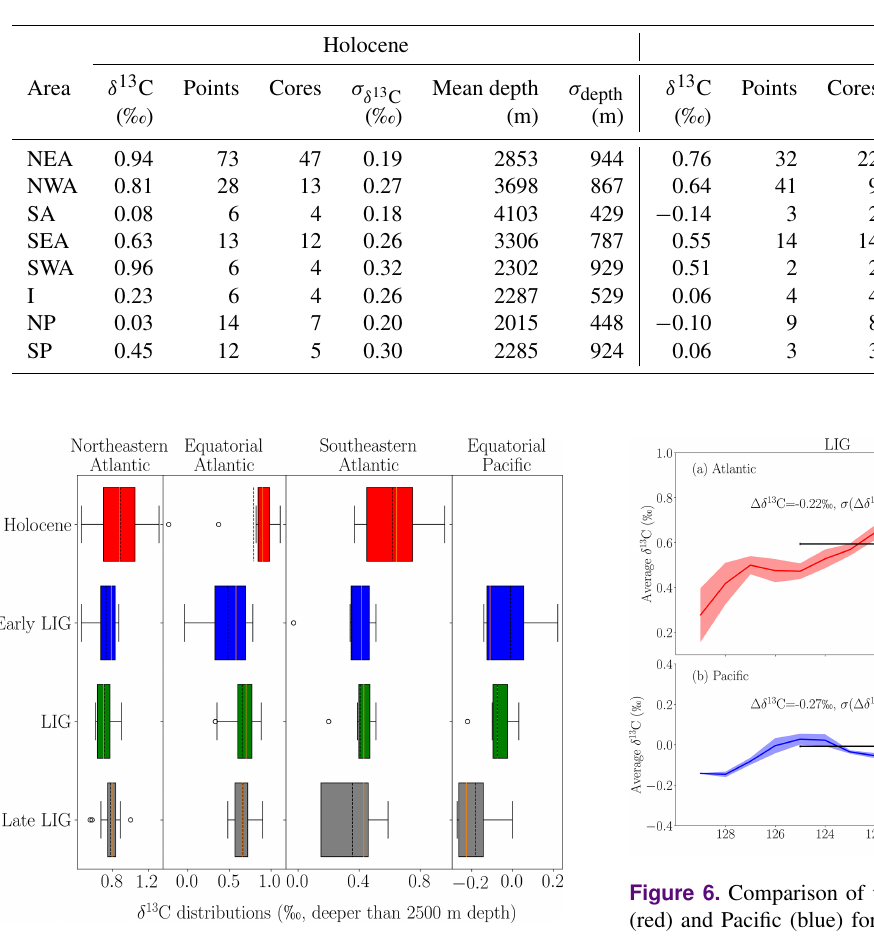
Figure 5. Distributions of δ 13 C for all core measurements deeper than 2500m during the Holocene (7–2kaBP, red), the early LIG (128–123kaBP), the LIG (125–120kaBP), and the late LIG (123– 118kaBP) across four regions (equatorial Pacific, equatorial At- lantic, southeastern Atlantic, northeastern Atlantic). The lower end of the box indicates quartile 1 (Q1), and the upper end indicates quartile 3 (Q3). Orange vertical lines show the median, and dotted vertical lines show the mean. The whiskers indicate the lower and upper fences of the data calculated as Q1 − 1.5 × (Q3 − Q1) and Q3 + 1.5 × (Q3 − Q1), respectively, and the clear circles are out- liers.